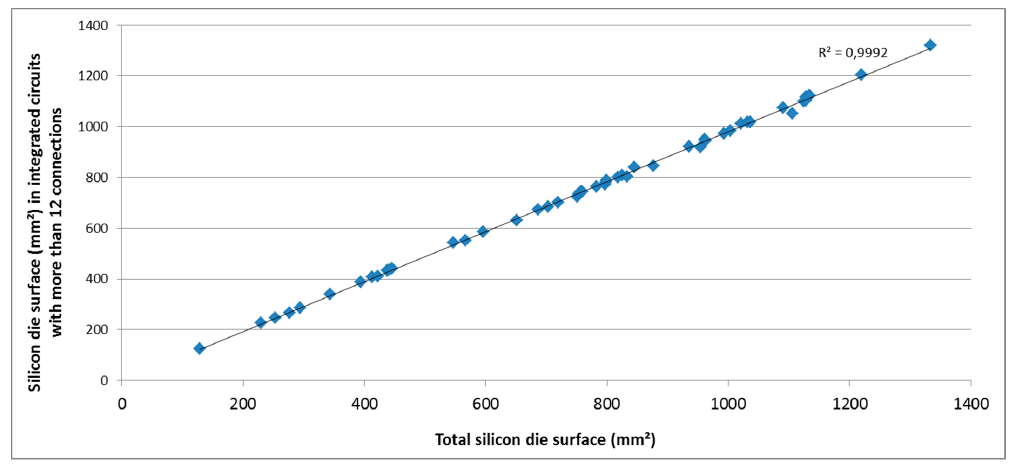
Figure 2. Assessment of the silicon die surface contained in the largest ICs with 50 mobile phones.